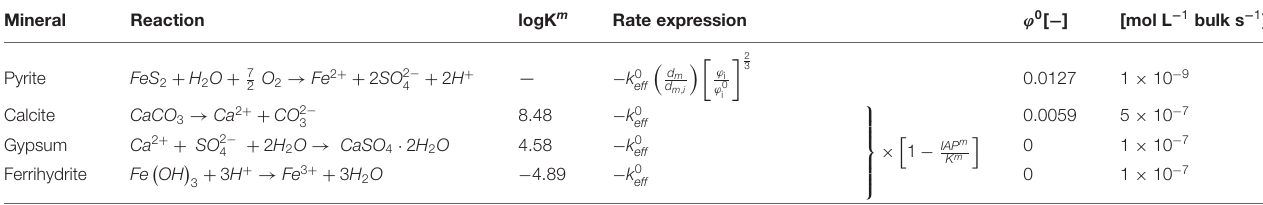
TABLE 2 | Mineral rate expressions for stylistic models.